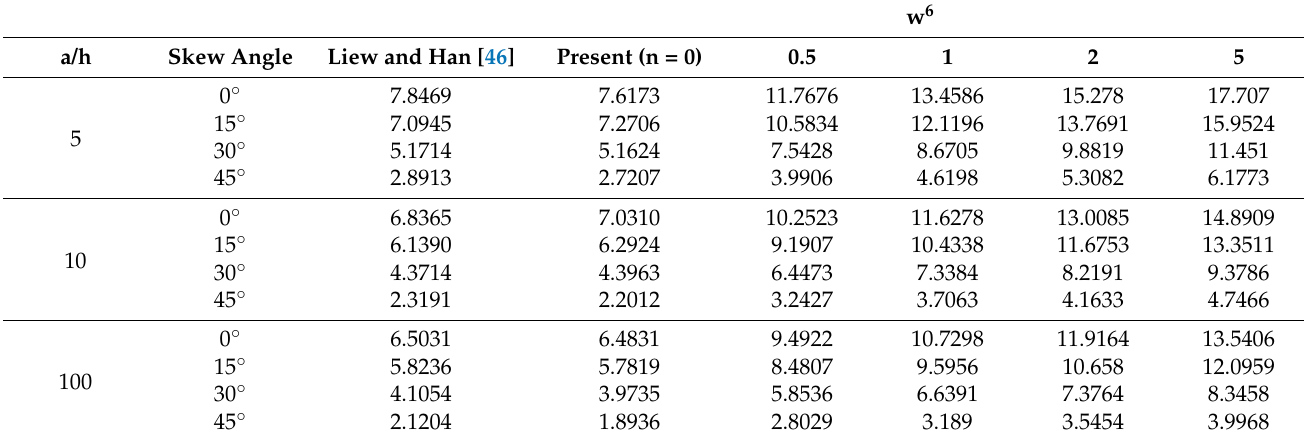
Table 9. Effect of the skewness angles on the non-dimensional central deflection (w6) of the simply supported FGM plate.